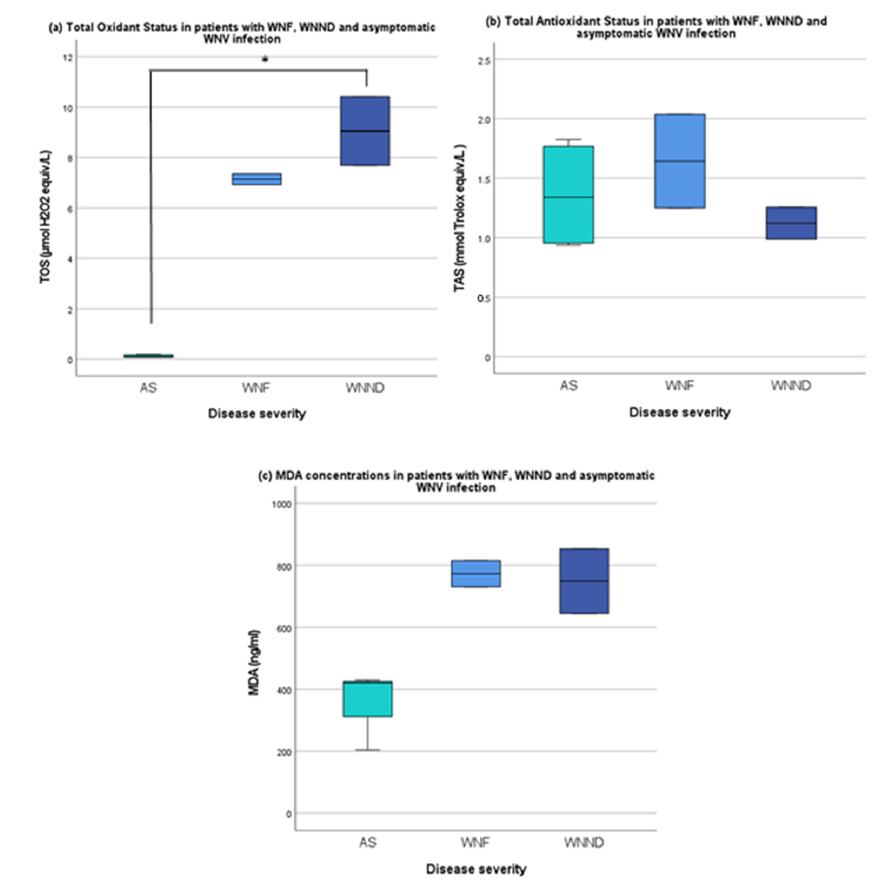
Figure 1. Boxplots of TOS ( a ), TAS ( b ) and MDA levels ( c ) in WNV-infected patients from Israel, per disease severity subgroup. Legend. ( a ) TOS (median) 9.1, IQR [8.4–9.7], 7.1 [7.0–7.3] and 0.1 [0.1–